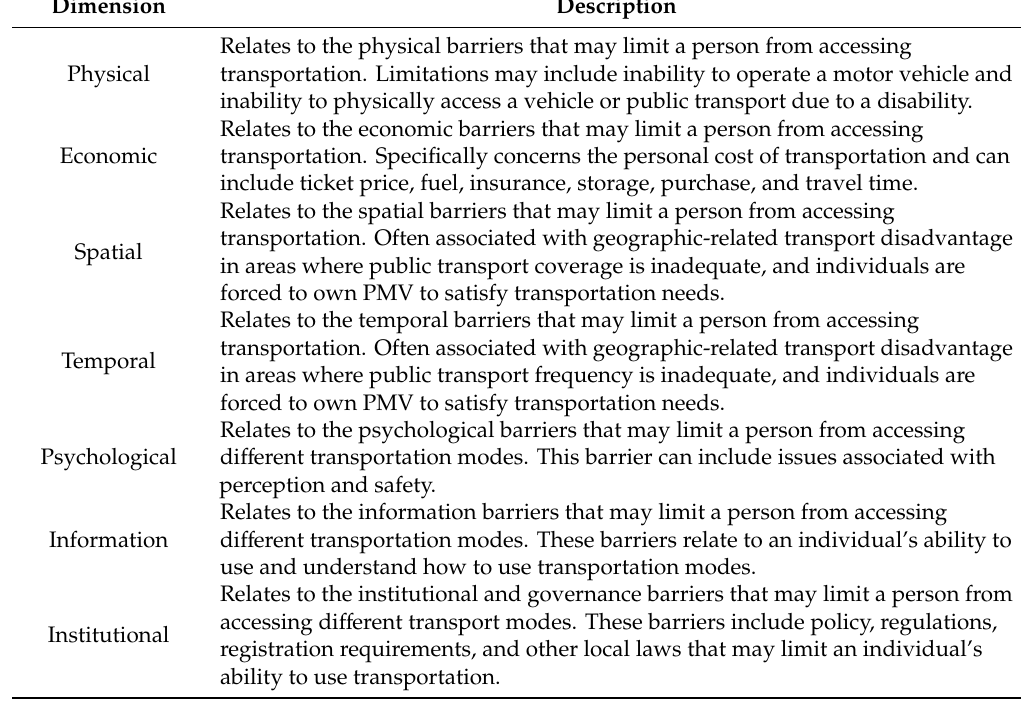
Table 1. Dimensions of transportation disadvantage (derived from